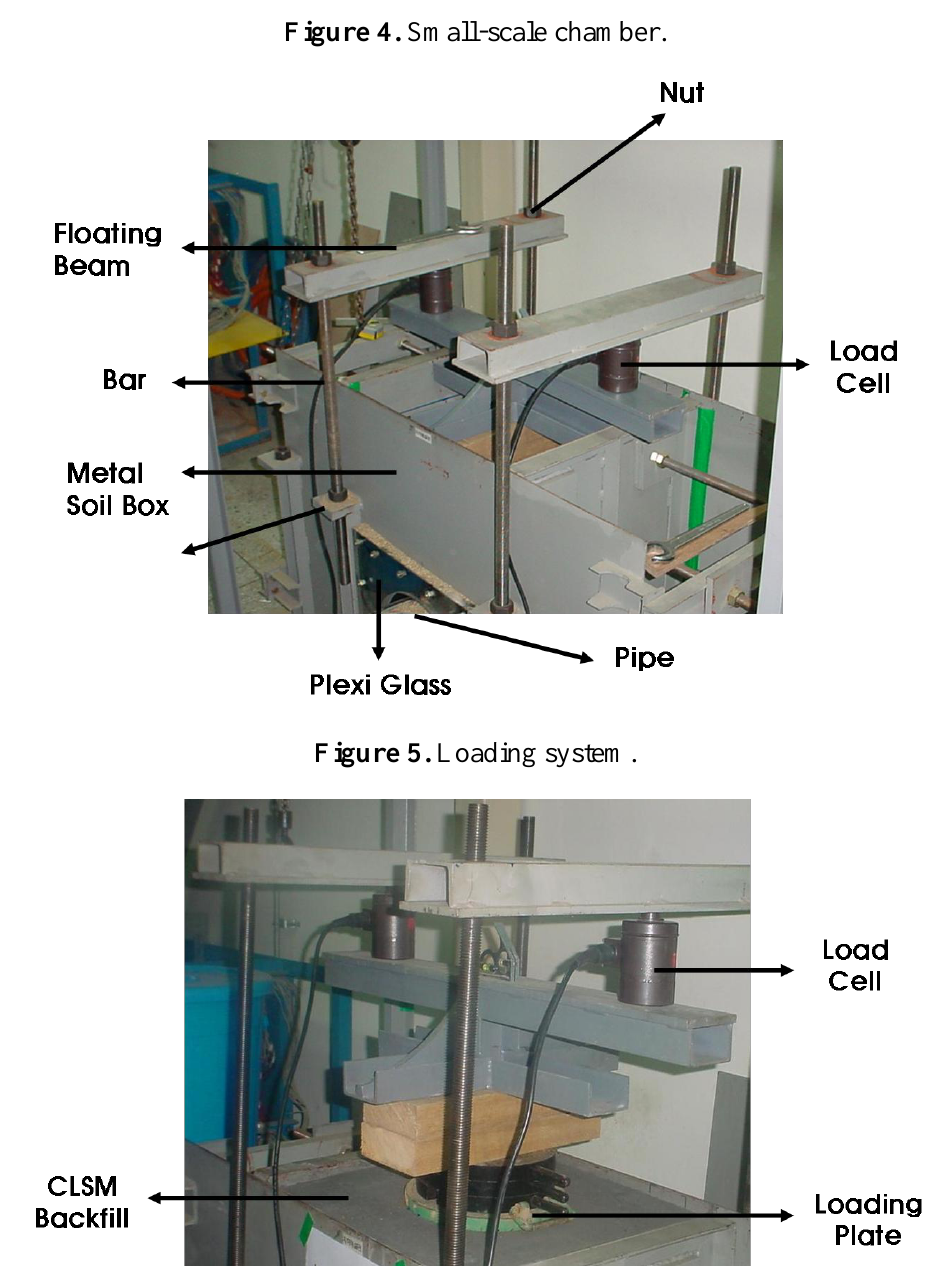
Figure 4. Small-scale chamber.